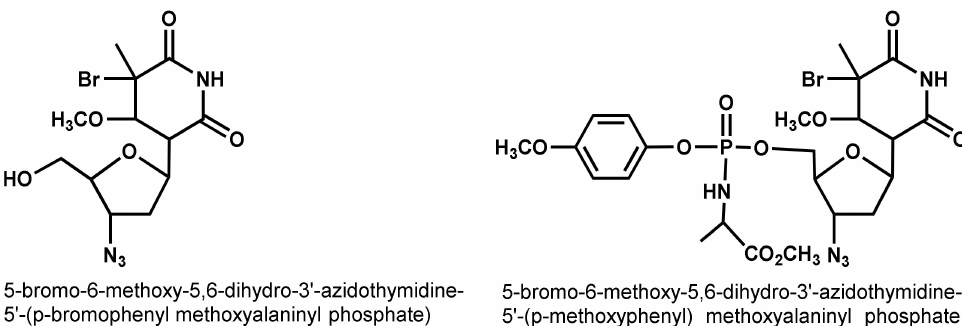
Figure 4. Chemical structures of zidovudine derivatives as the potential spermicides and anti-HIV